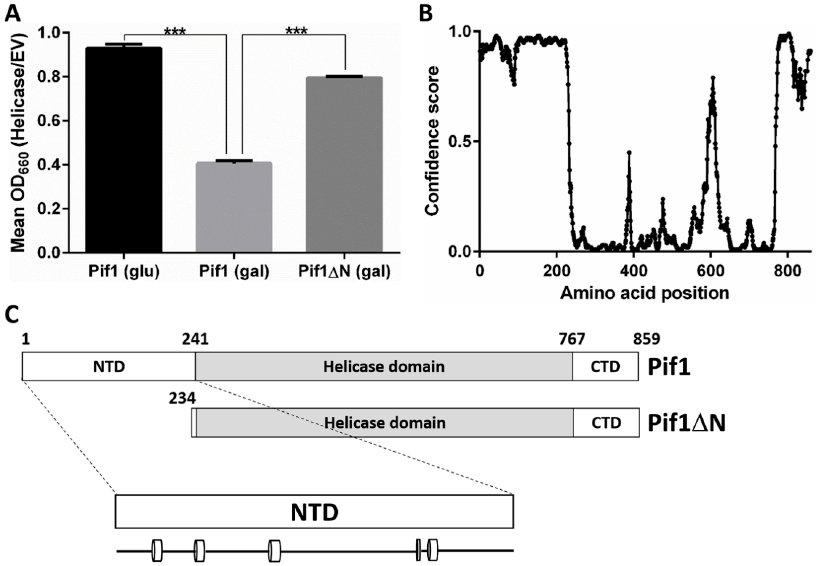
Figure 1. The disordered N-terminus of Pif1 is involved in Pif1 overexpression toxicity . ( A ) Removal of the Pif1 N-terminal domain (NTD) relieves the toxicity of Pif1 overexpression in S. cerevisiae . Galactose-inducible expression vectors for Pif1 and Pif1 Δ N, as well as empty vector (EV) were transformed into wild-type cells, and the growth of these strains was monitored at an optical density of 660 nm (OD 660 ) for 48 h. The mean OD 660 during the entire time course of the cells containing the Pif1 or Pif1 Δ N expression vectors was normalized to that of cells containing the empty vector to compare growth in the absence of induction (glu) and upon chronic overexpression (gal). The graphed values represent the average of ≥ 3 independent experiments, and the error bars correspond to the standard deviation. *** p < 0.0001. ( B ) The NTD of Pif1 is predicted to be natively disordered. The primary sequence of S. cerevisiae Pif1 was analyzed using the DISOPRED3 disorder prediction program [25], and the predicted disorder is plotted for each amino acid. The confidence score represents the likelihood that the amino acid resides in a disordered region. ( C ) Domain schematics of full-length Pif1 and Pif1 Δ N. The first ATP hydrolysis motif of the Pif1 helicase domain begins at residue 241 [9], but sequence alignments, domain prediction, and disorder prediction indicate that the helicase domain itself includes residues 234–240 as well. The predicted secondary structure within the Pif1 NTD is shown below, with cylinders denoting α -helices and the lines connecting them denoting random coil.